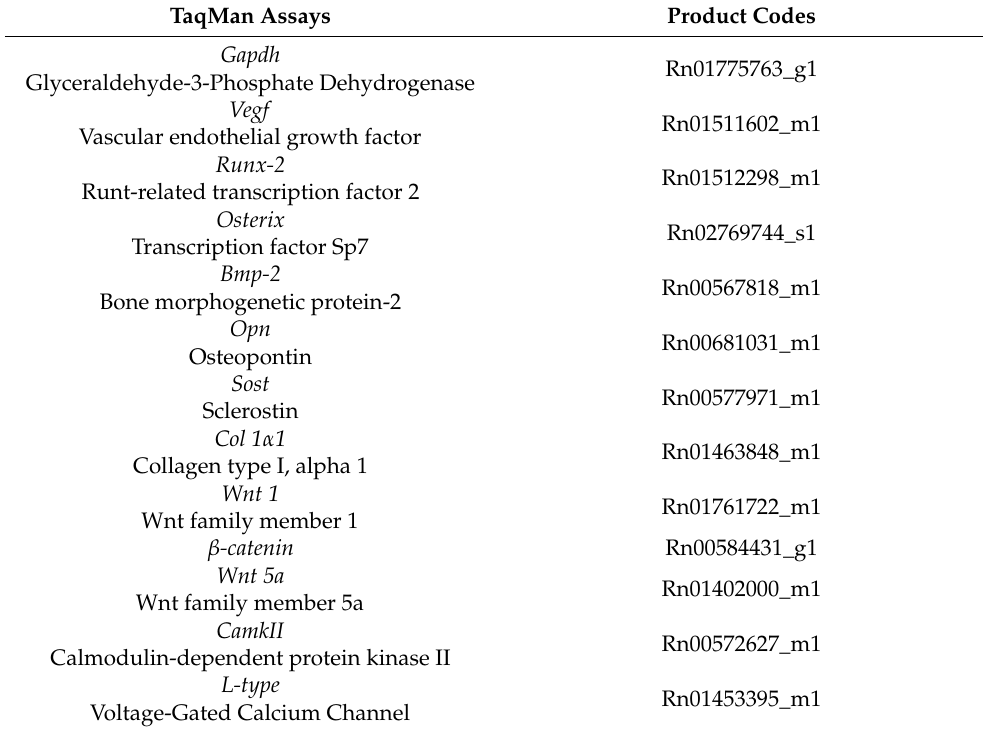
Table 3. TaqMan assays used for